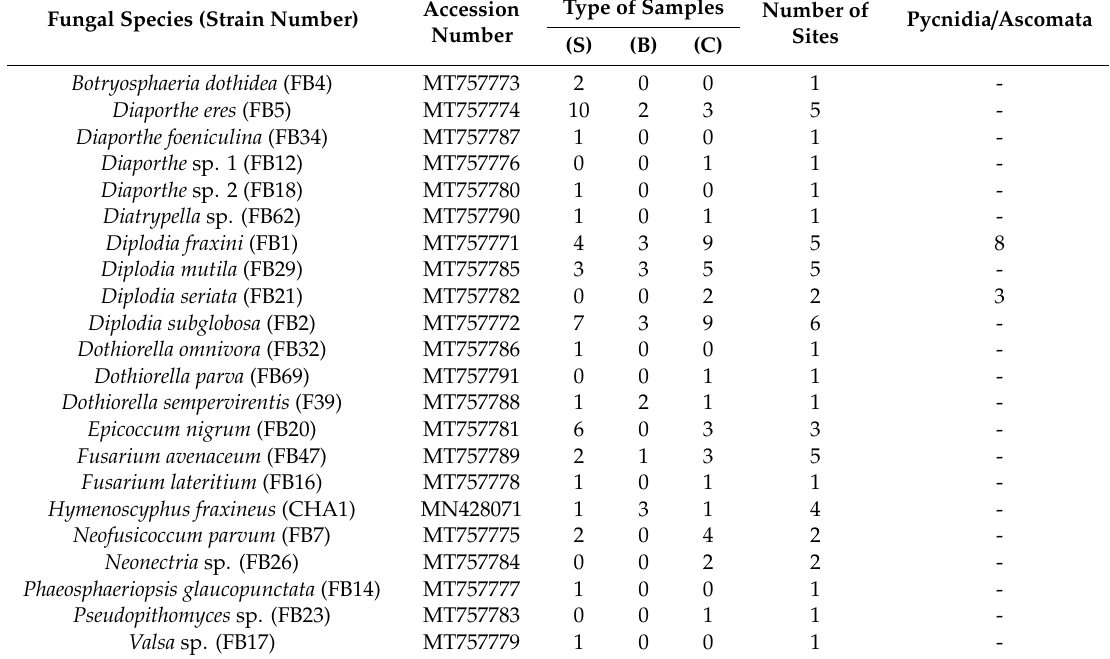
Table 2. Accession numbers deposited in GenBank and number of isolates of each species obtained from shoots (S), branches with brown inner bark discolorations (B) and branches with sunken canker (C). The number of branches with pycnidia or ascomata is reported in the last column. Fungal Species (Strain